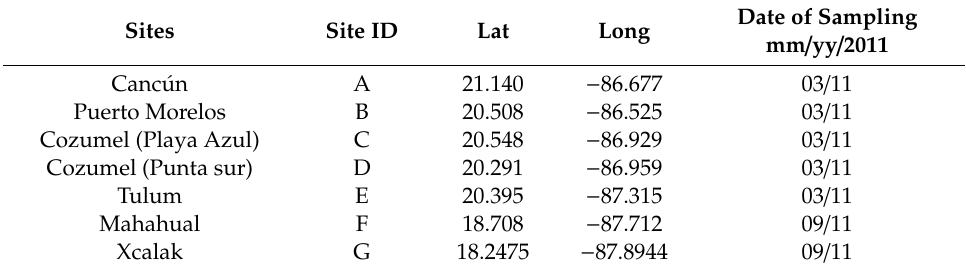
* Lat, latitude; Long,